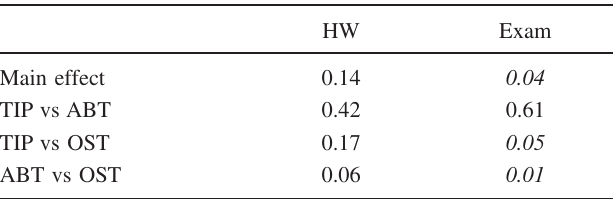
TABLE III. Probability (cid:1) p (cid:2) values computed using ANOVA. Values for the main effect and each post hoc comparison are dis- played. Values displayed in italics are significant, p (cid:2) 0.05